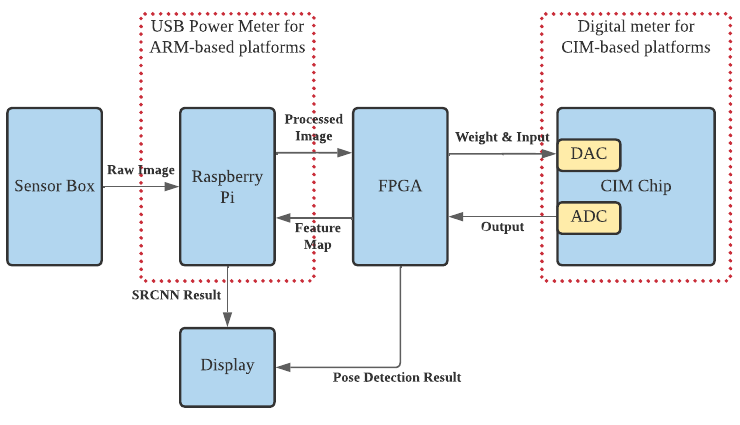
Figure 14. Energy Consumption Measurement for ARM- and CIM-based